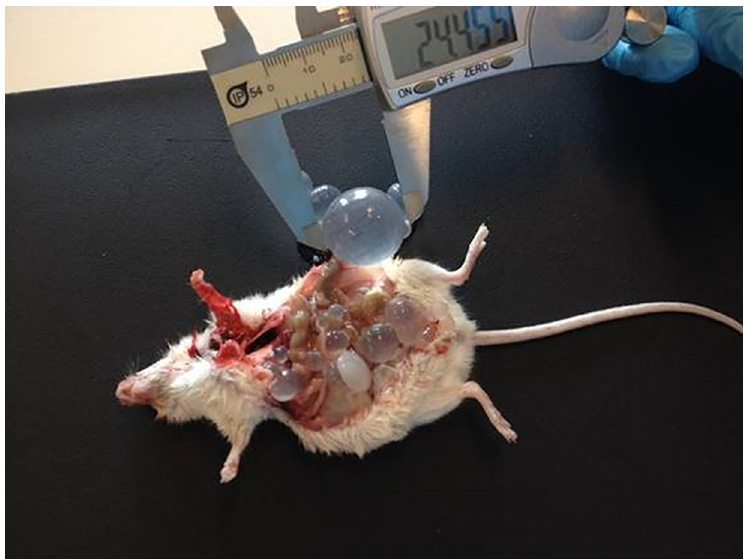
Fig 1. Mouse experimentally infected with Echinococcusgranulosus sensu stricto. Cysts of E . granulosus in the peritoneal cavity of an infected mouse. Image credit: Dr. Gulay Vural, Namik Kemal University, Turkey.